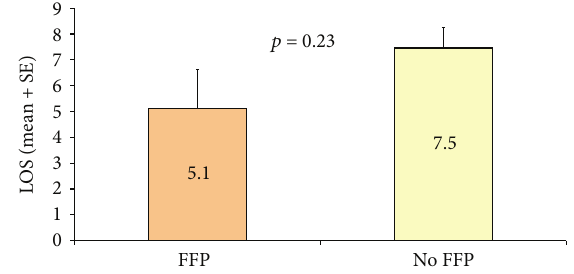
Figure 3: Difference in total hospital stays by group. FFP, fresh frozen plasma; LOS, length of stay; SE, standard error.